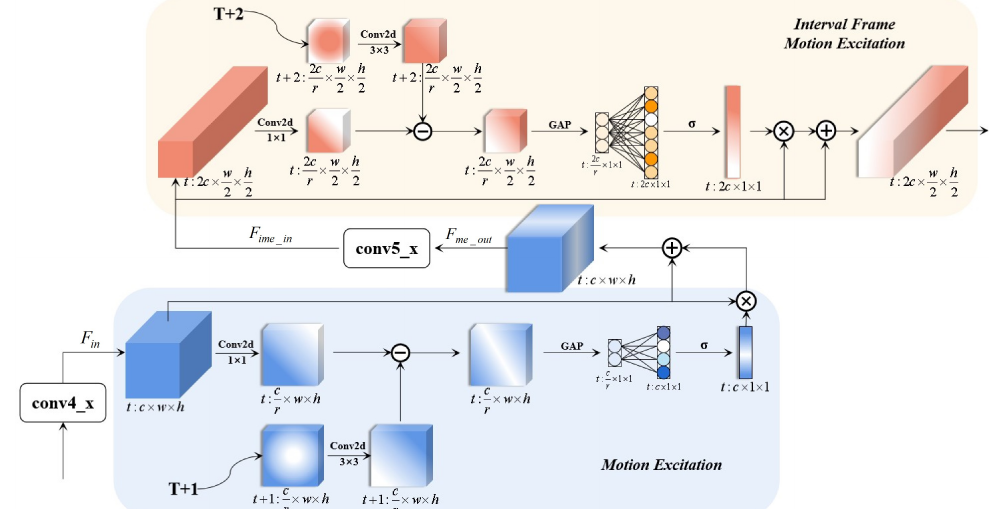
Figure 2. Internal processing of the HME module. It includes two parts: Motion Excitation (ME) and Interval Frame Motion Excitation (IFME). t , t + 1, and t + 2 respectively represent the current frame, adjacent frame, and interval frame. GAP represents the average pooling operation. σ represents the Sigmoid activation function. F in is obtained through the processing of conv 1_ x to conv 4_ x in ResNet50. F in first uses the ME structure to obtain the feature-level motion pattern of the adjacent frames. Input feature F ime _ in of the IFME module is obtained by performing the residual operation of conv 5_ x in ResNet50 on F me _ out . In the IFME structure, the alignment feature of the ( t +2 ) -th frame and t -th frame is used to perform frame difference calculation. The channel attention mechanism is used to fuse the feature-level motion transformation of the interval frame into the original